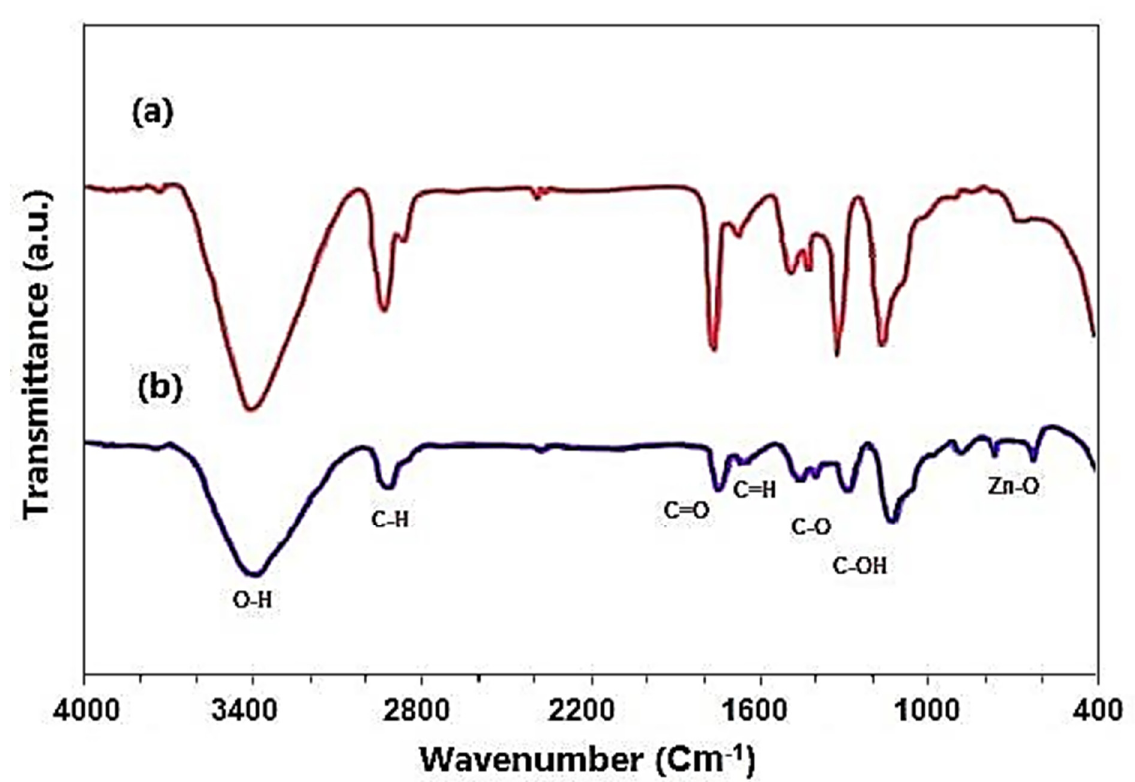
Figure 5. FTIR spectrum of phlomis leaf extract (a) and (b) synthesized ZnO NPs.